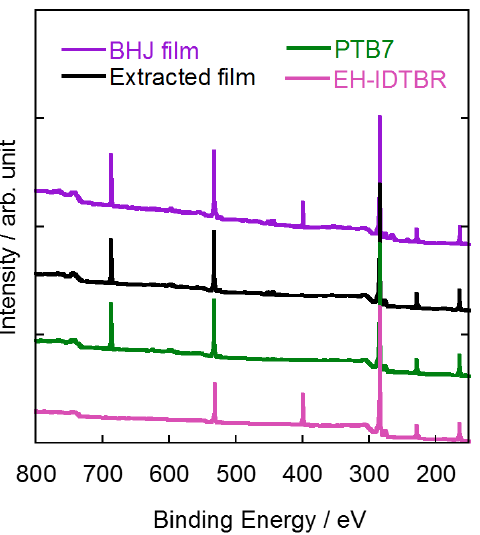
Figure 3. XPS spectra of BHJ films before and after extraction and of pure films of PTB7 and EH- IDTBR.